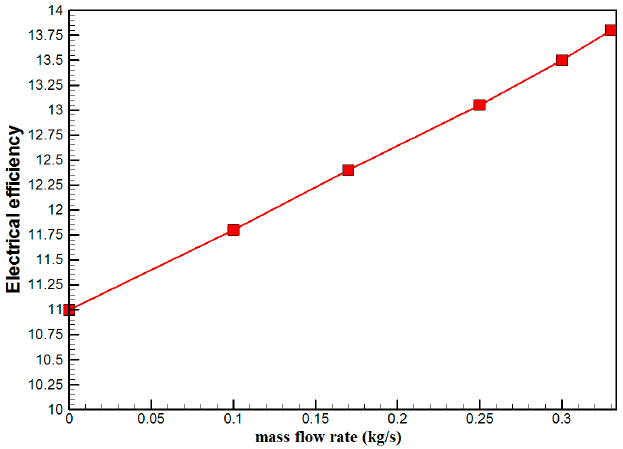
Figure 15. The hourly variation of output power for the PVT solar collector with CPC for different mass flow rates of water.